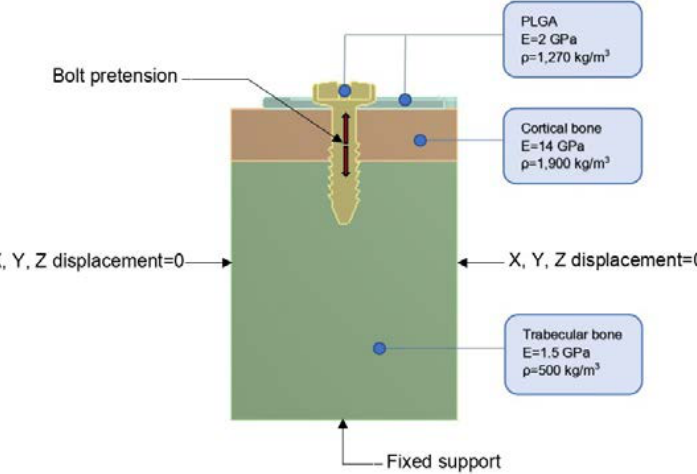
Table 2. Mechanical properties assigned for finite element method (FEM) analysis.